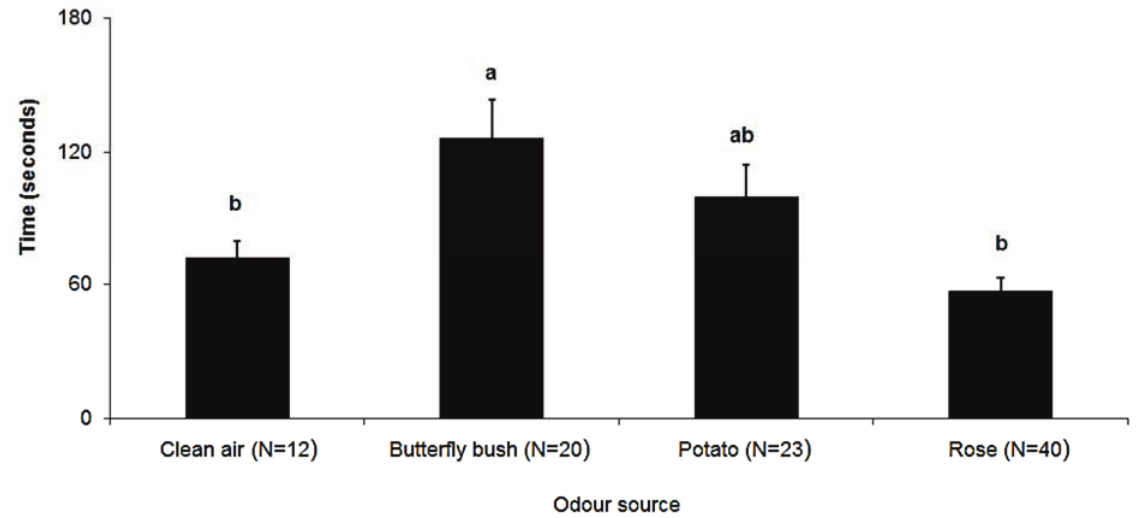
Figure 2. Mean time (X ± SEM) taken by M. euphorbiae gynoparae to reach different odour sources in wind tunnel assays (N = number of responding males). Columns with different letters are significantly different (Tukey’s HSD, p < 0.05).